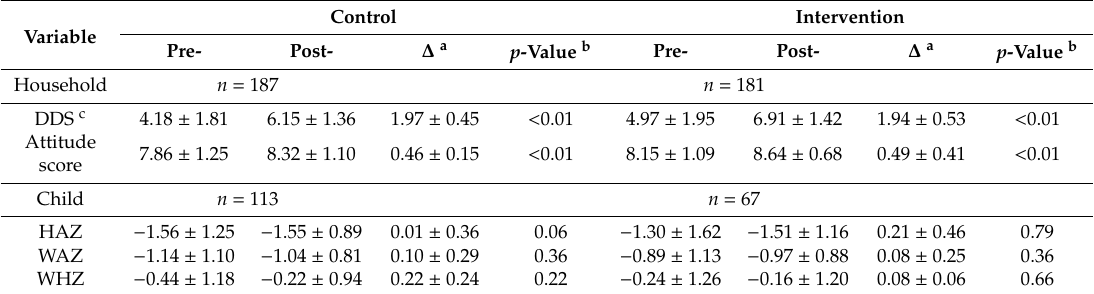
Table 2. Di ff erences between pre- and post-intervention in household diet practices and child growth. Control Intervention Variable Pre- Post- ∆ a p -Value b Pre- Post- ∆ a p -Value